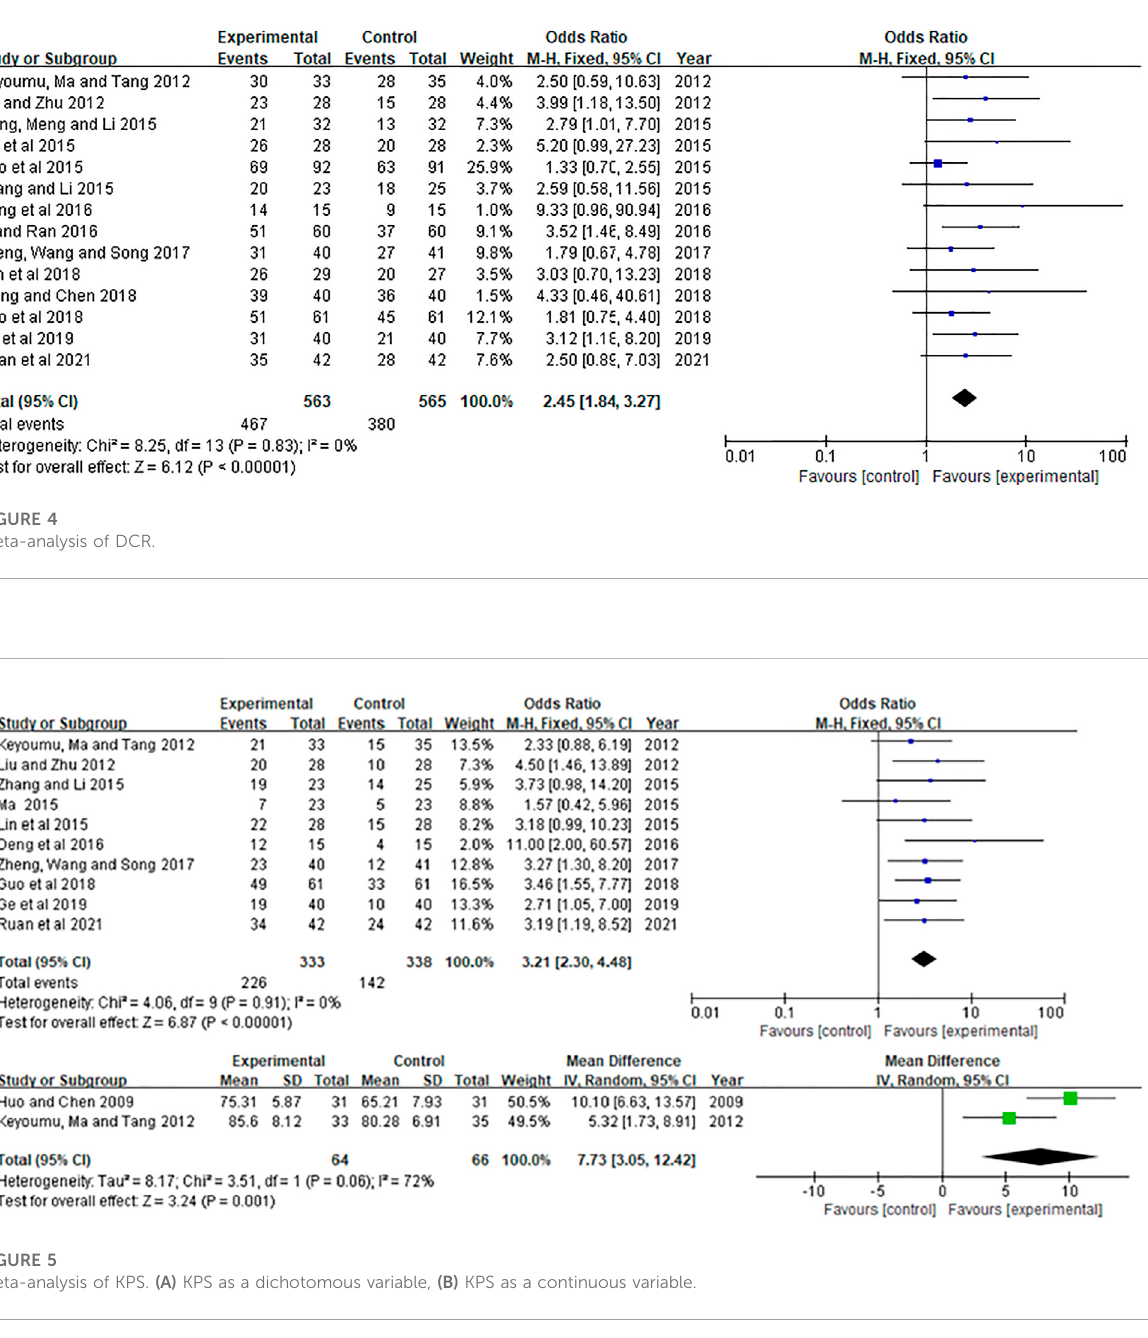
FIGURE 5 Meta-analysis of KPS. (A) KPS as a dichotomous variable, (B) KPS as a continuous